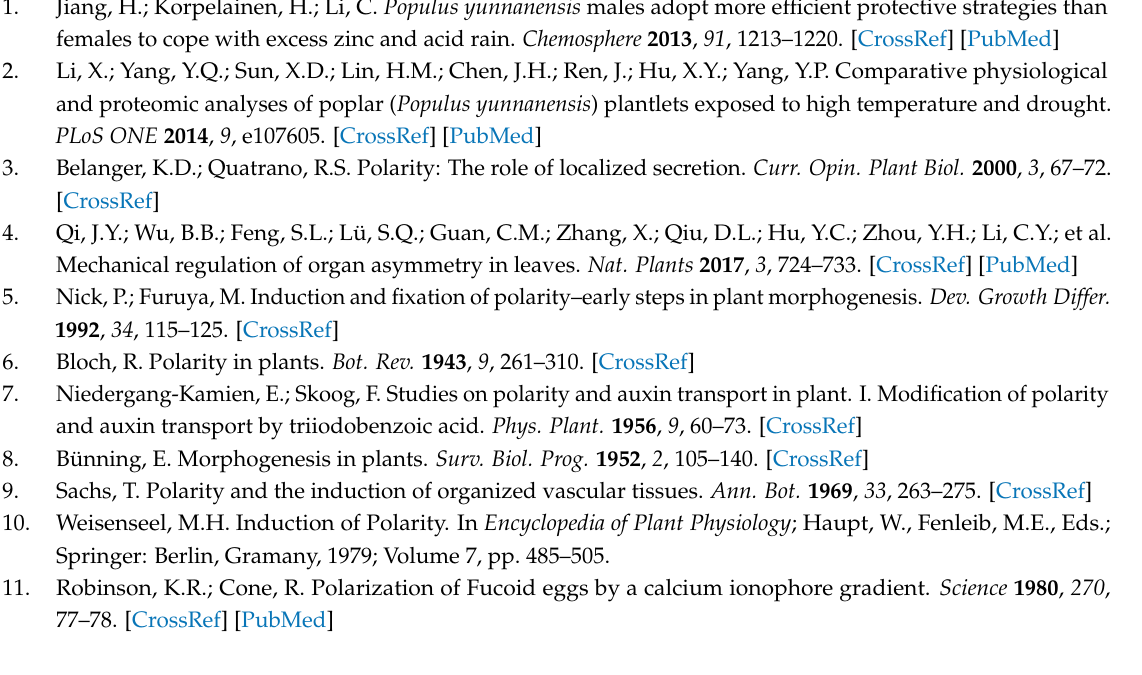
Table S1: Information for ten selected DEGs. Figure S1: Vegetative form of upright and inverted cuttings of P. yunnanensis . Figure S2: Confirmation of RNA-Seq results using